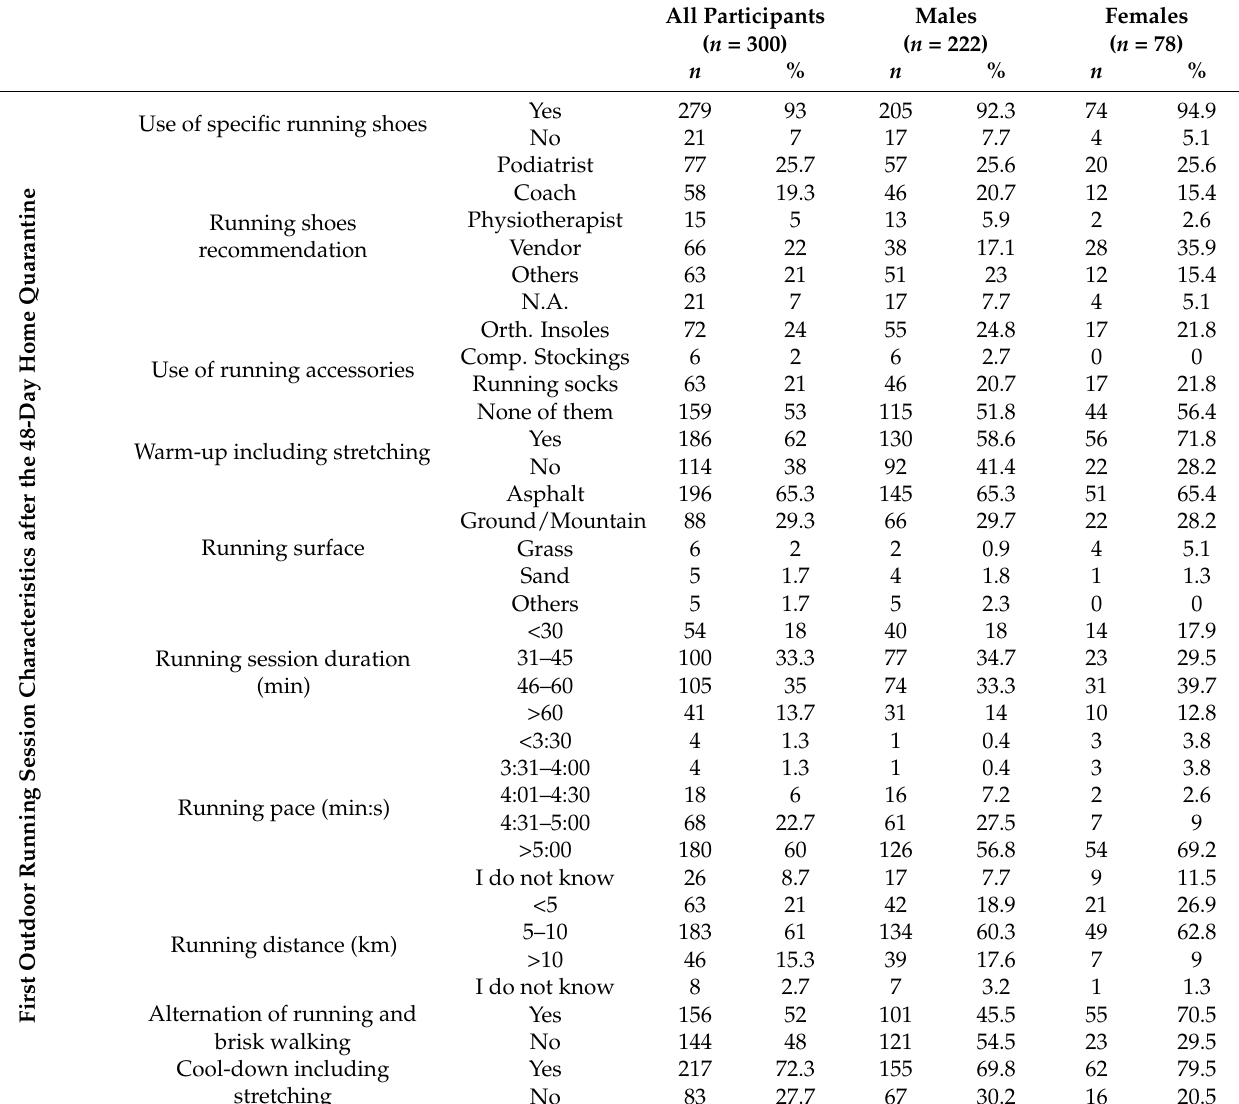
Table 3. Characteristics of the first outdoor running session after the 48-day home quarantine of recreational runners in